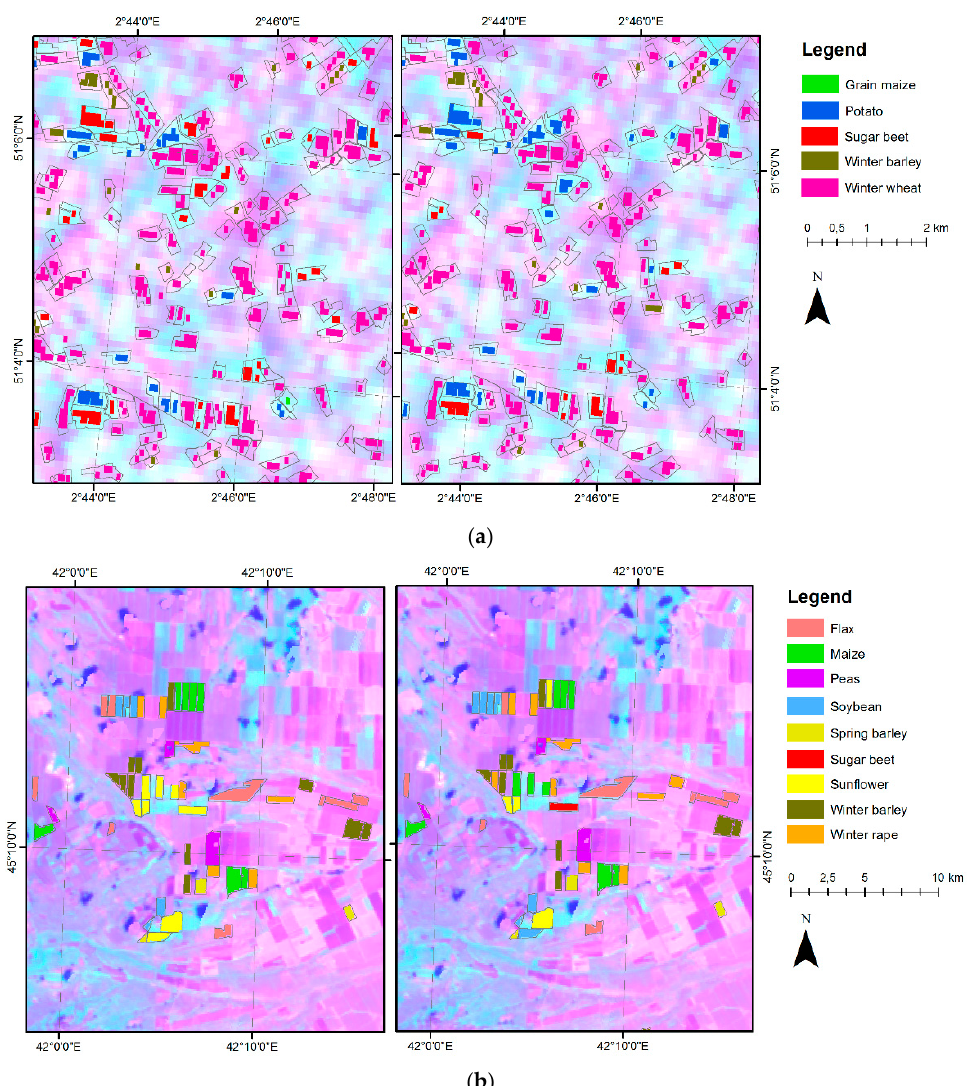
Figure 5. Comparison of the classification results based on pure pixels during the entire growing season for a selected area in Flanders-Belgium ( a ) and Sria, Russia ( b ). ( Left ) The overlay of Proba-V and ground/field data; ( right ) the overlay with the post-classification results.